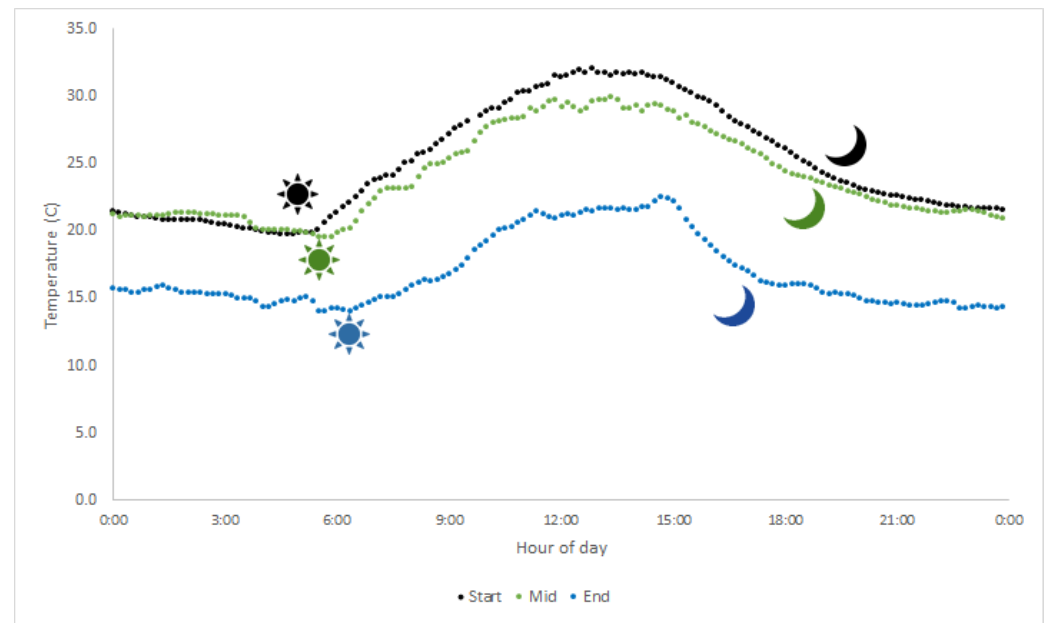
Figure A2. Mean temperature records, collected at 10-min intervals, for the dates on which flowering progression was monitored in 2018. The sun and moon symbols indicate the times of sunrise and sunset on the monitoring